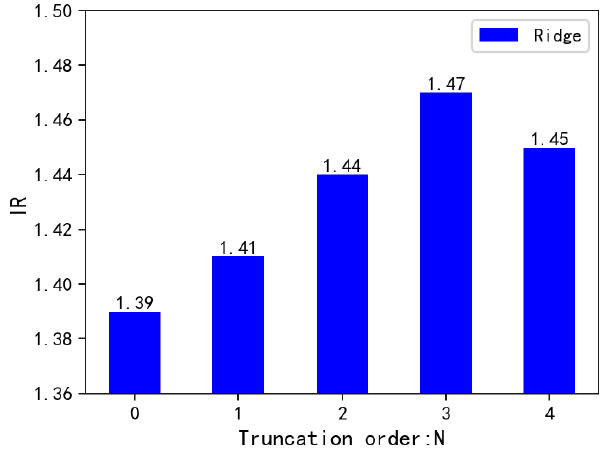
Figure 6. Improved ratio